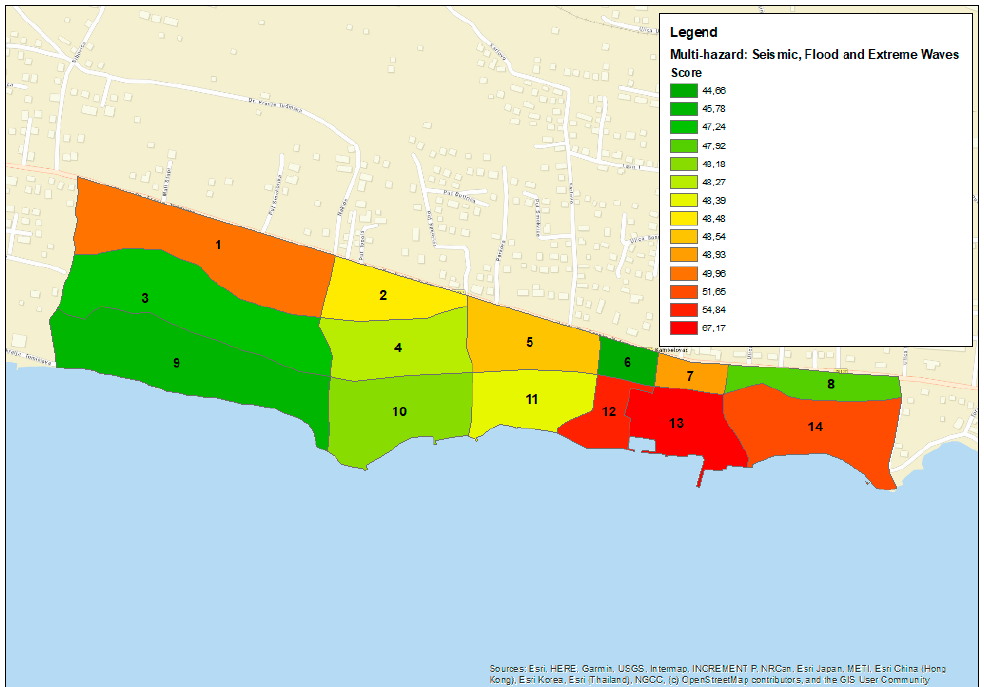
Figure 23. GIS visualization of risk for seismic, flood and extreme waves hazard for Level 3 (Scenario S-F-EW L3).